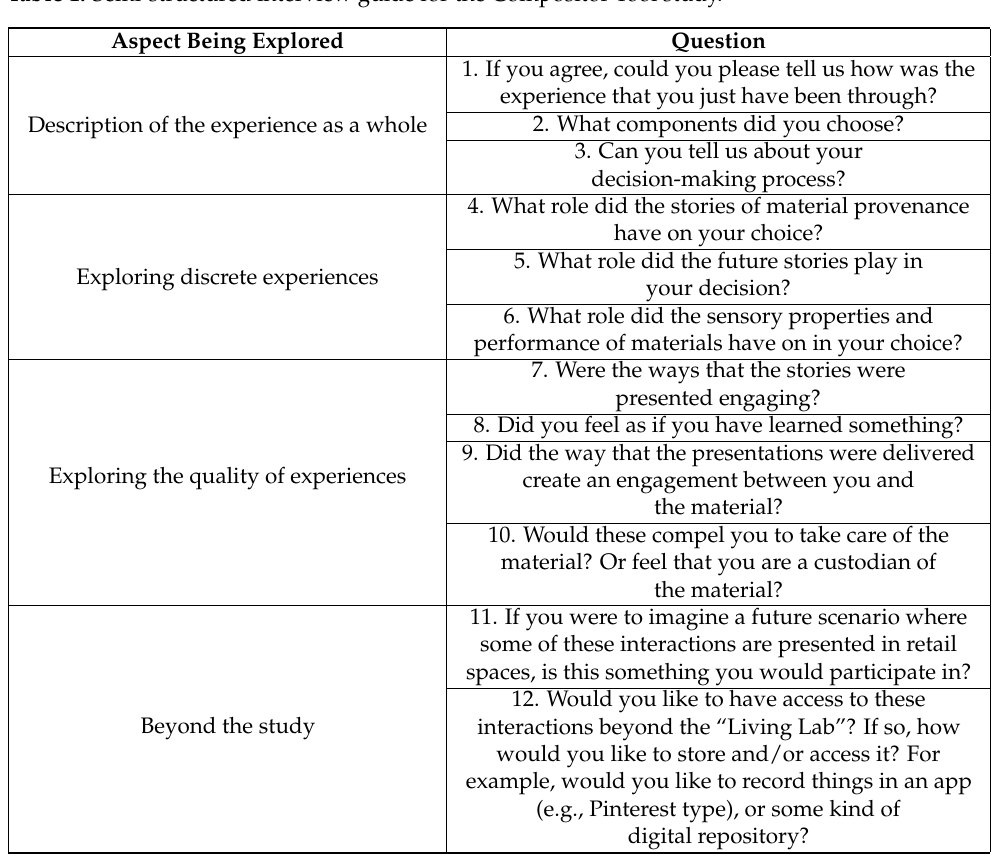
Table 1. Semi-structured interview guide for the Compositor Tool